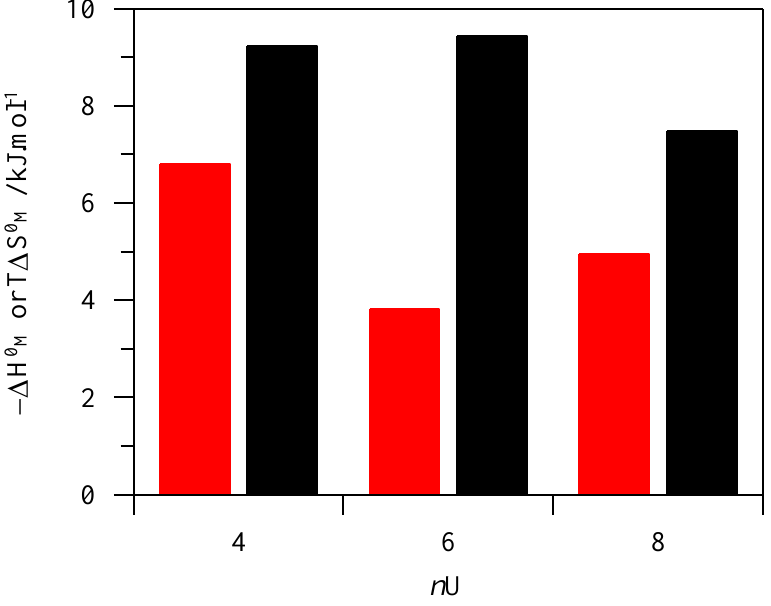
Figure 7. Variation of the enthalpy (red bars) and entropy (black bars) of micellization with the number of monomeric units ( n U) present in the structure of the amphiphilic p -sulfonatocalix[ n ]arenes. All data is given in kJ·mol −1 of alkyl chain